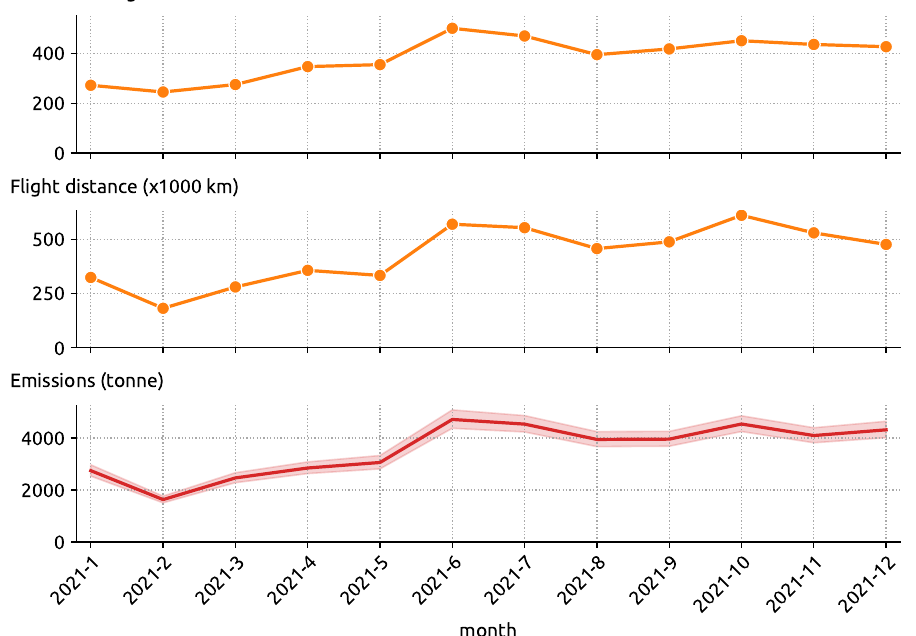
Figure 3. Total flights, distance, and emissions caused by 67 aircraft that requested to be removed from OpenSky over the year